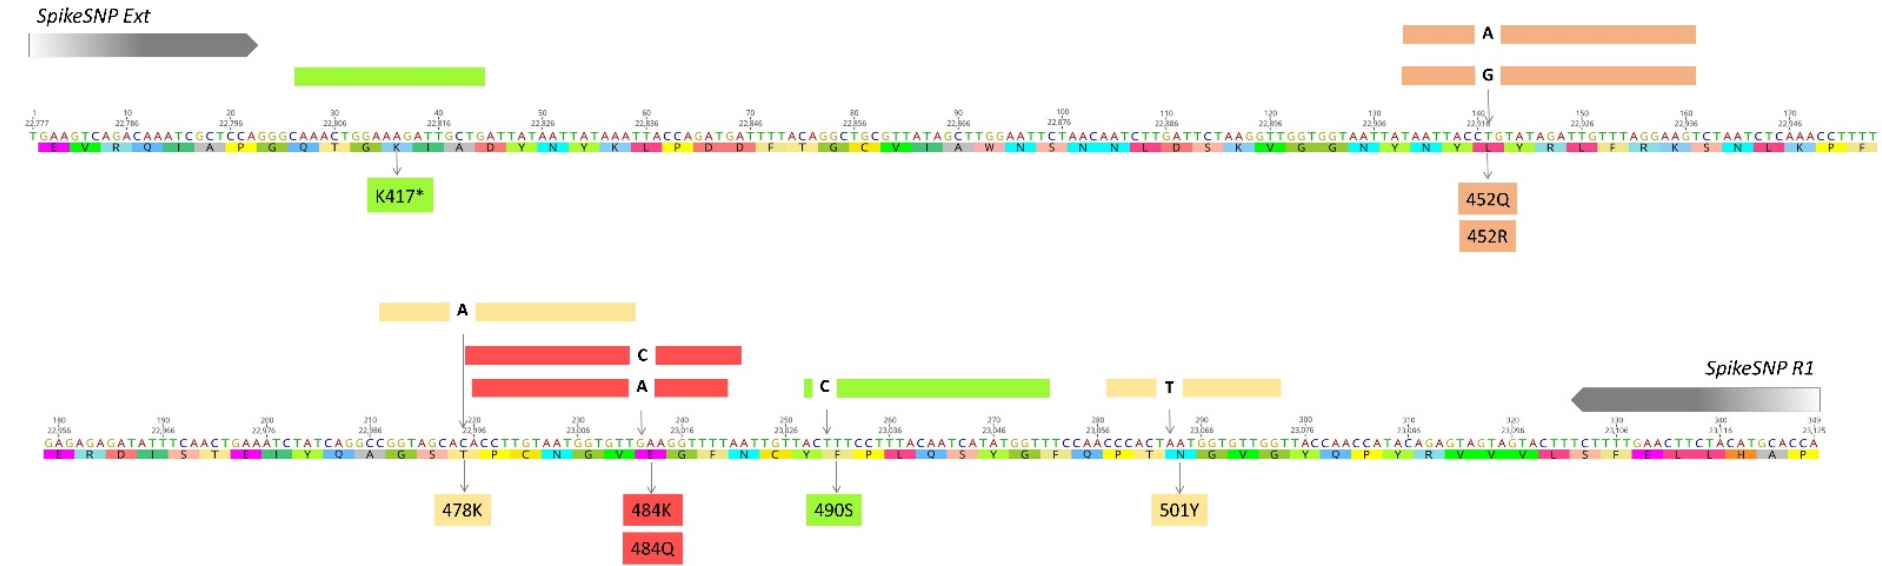
Figure 1. Graphical display of the 348-base-pair Spike SNP target, including the nucleic acid sequence and amino acid translation of the Wuhan-Hu-1 strain (NC_045512.2). The locations of the forward and reverse primer sequences and all hydrolysis probes are shown. Probe colors correspond to the fluorophores on each probe and the detection channel in the Rotor-Gene Q instrument. Detected nucleotide changes are displayed within the probe, and amino acid mutations are shown below the sequence. The probe for K417 is marked (*), as this is the only probe for which variant sequences result in signal loss and this has only been successfully designed with locked nucleic acid (LNA) bases.